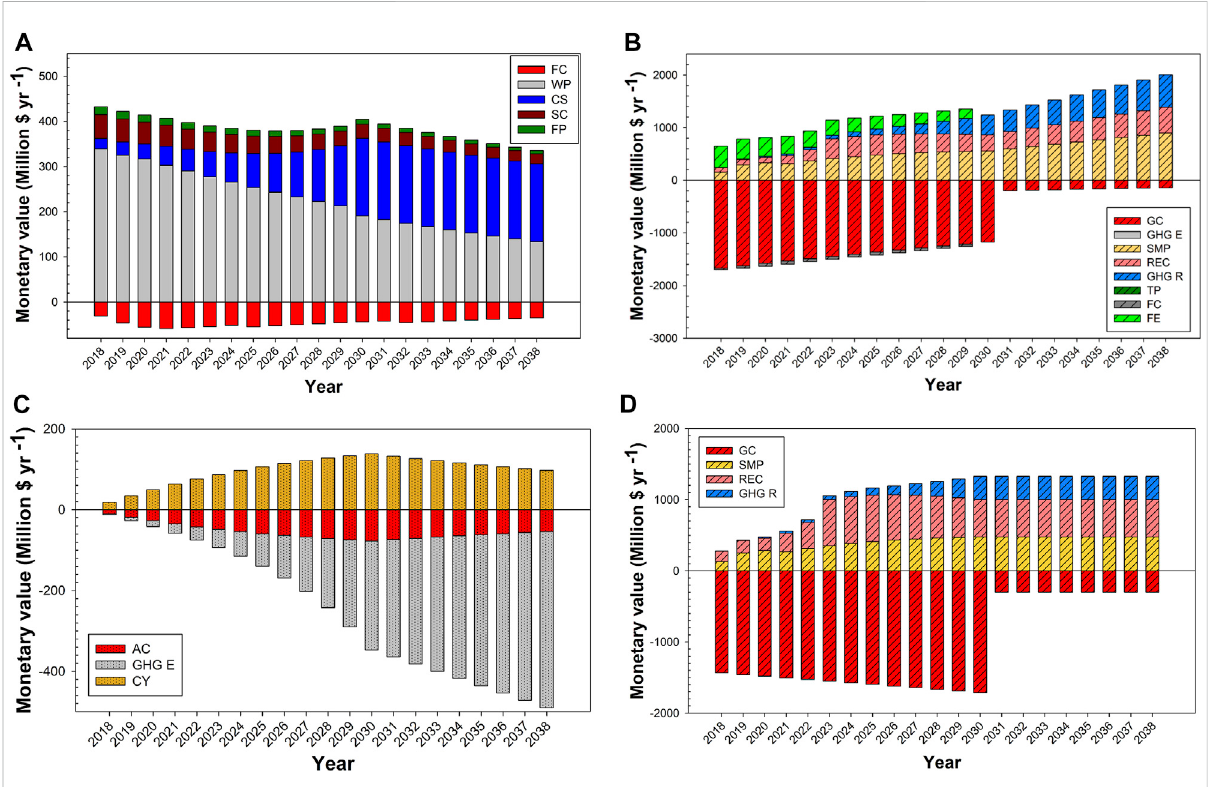
FIGURE 4 Present value of cost and bene fi t from forest under Scenario 1 (A) , and Scenario 2 (B) , and from agricultural land under Scenario 1 (C) , and Scenario 2 (D) (FC: Forest management cost, WP: Water provision, CS: Carbon sequestration, FP: Forest resource production, GC: Generation